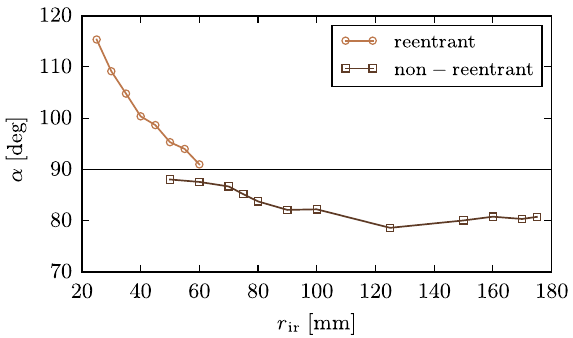
FIG. 6. Optimal tangential angle as a function of the iris radius r . The transition between a reentrant and non-reentrant elliptical ir ∼ 60 mm. cavity is at r ir